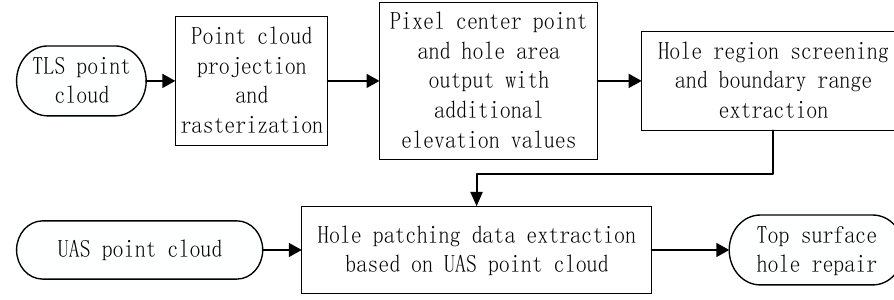
Figure 3. TLS point cloud top surface hole repair